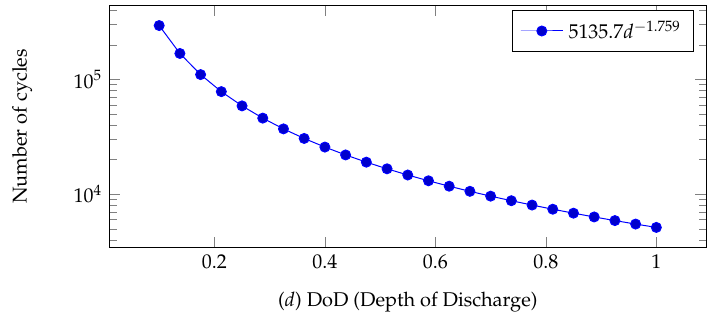
Figure 2. Fitted curve for a real-life Li-ion